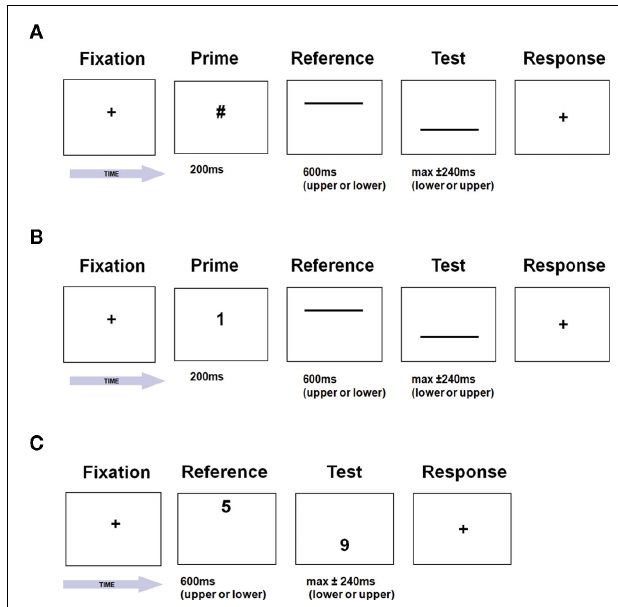
FIGURE 2 | Experimental design in the (A) symbol and (B) the number prime conditions, participants judged which of two horizontal lines lasted longer, with the reference line preceded respectively by a non-numerical (“#,” Symbol Prime Condition) or a numerical prime (“1” or “9,” Number Prime Condition). In the “1–5–9” Condition (C), participants judged temporal durations directly onArabic numbers